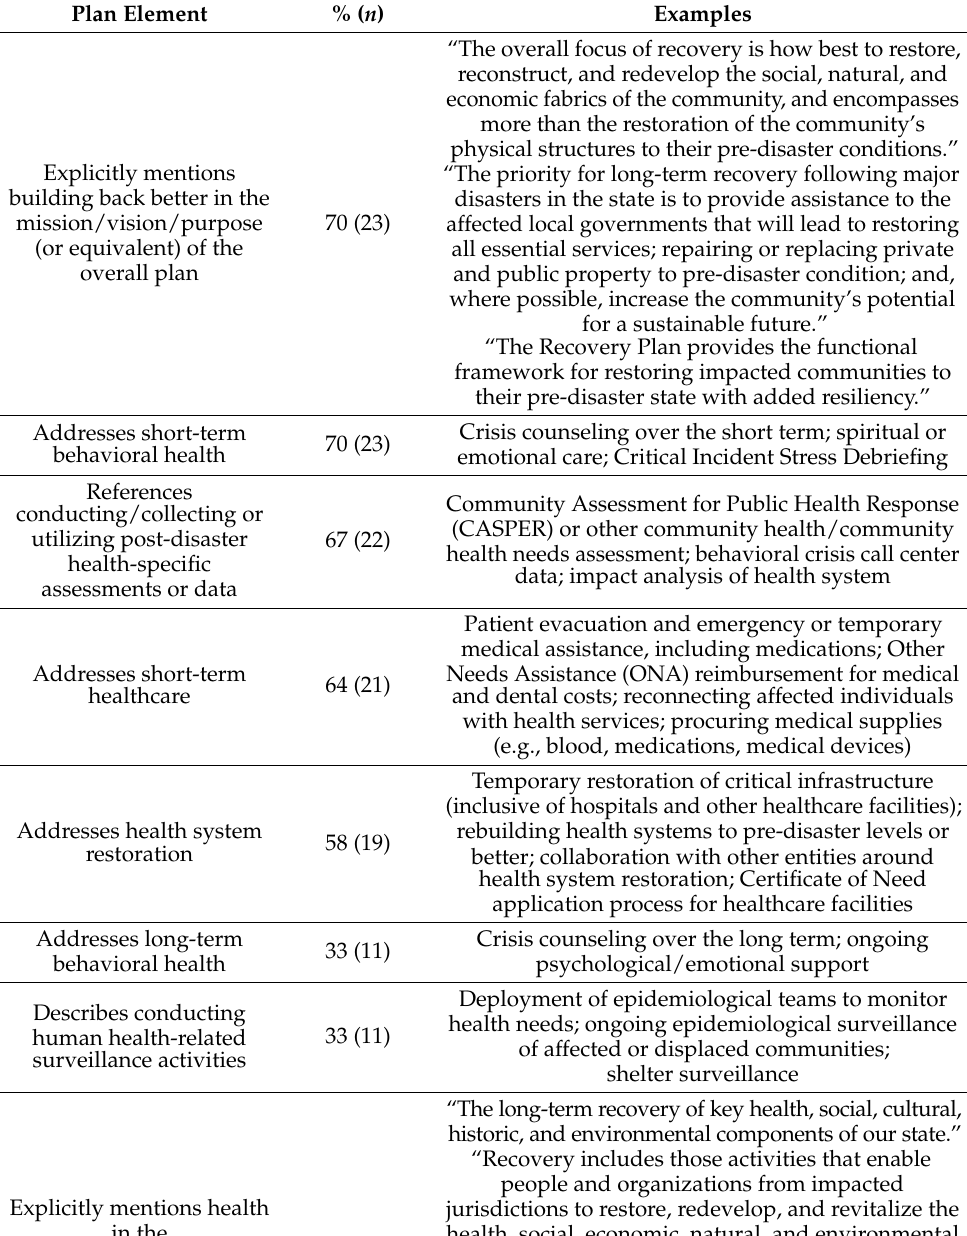
Table 2. Health-Related Activities or Actions in State Disaster Recovery Plans ( n =